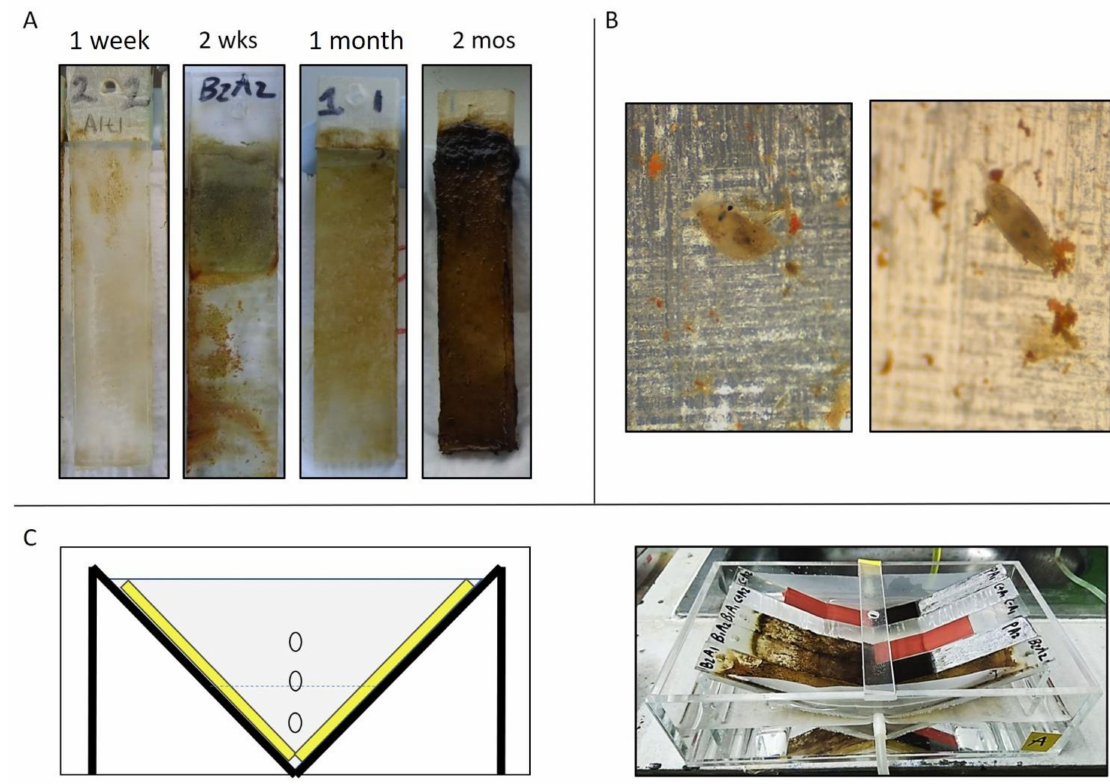
Figure 1. Upper-left panel ( A ): photographs of some of the plates with different biofilm age (from 1-week to 2-months) used for settlement experiments and image analysis (see material and methods for details). Upper-right panel ( B ): two photographs of cyprids of Notobalanus flosculus settling in the biofilm plates ( C ) schematic drawing of a lateral view of the V-shaped stand placed in the outer aquarium used in the settlement experiments and a photograph of the stand with the experimental plates mounted. In the drawing, the grey-shaded triangle represents the 90 µ m nylon mesh used to constrain larvae during the trial, the yellow rectangle represents the experimental plates, and the dashed blue line represents the level of water within the aquarium (see material and methods for